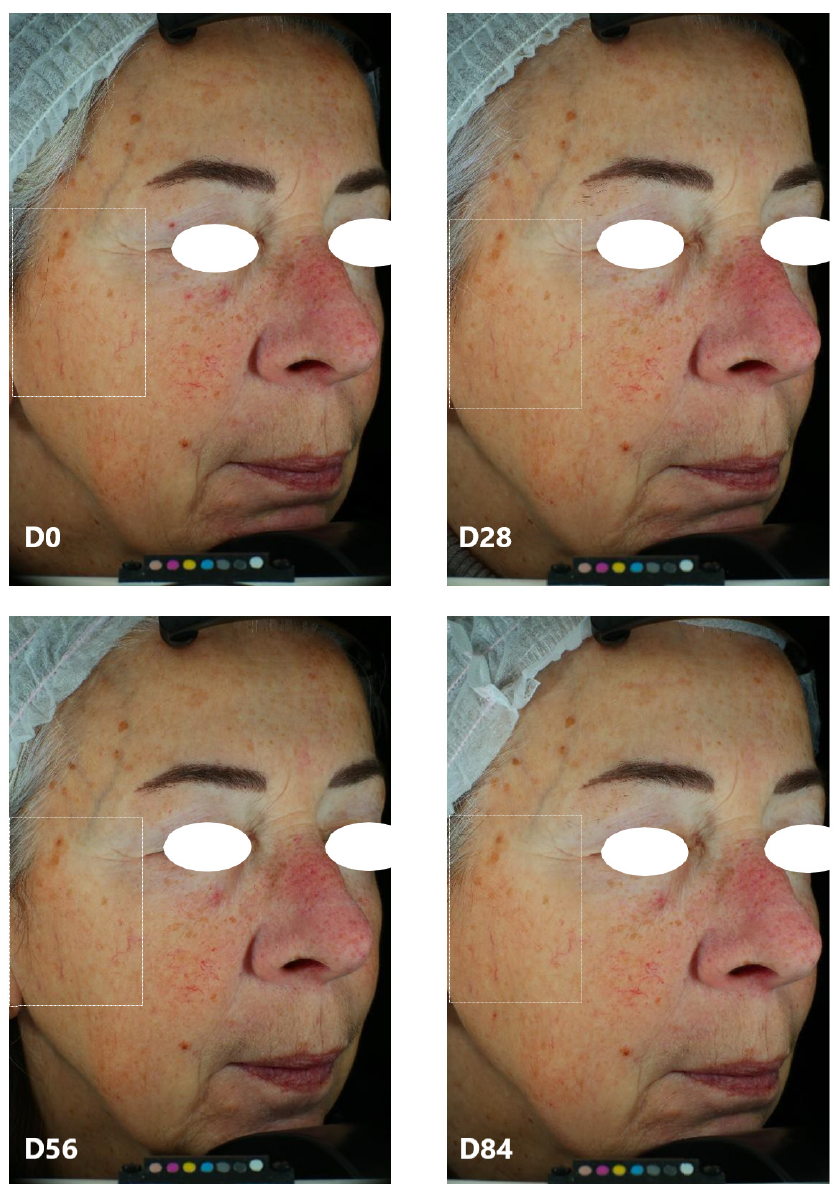
Figure 5. Representative pictures of one volunteer (vol 41) before and after 28, 56, and 84 days of treatment with the EY ingredient. Digital pictures were acquired by means of VISIA CR (Canfield Imaging Systems, Fairfield, NJ). Starting from D28, dark spots are less evident and the skin’s complexion is more uniform.